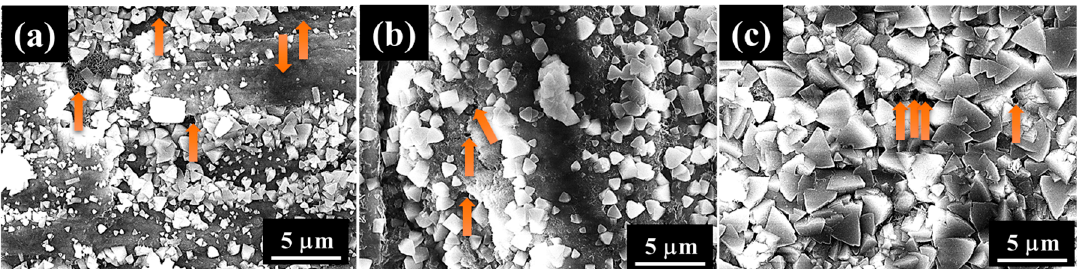
Figure 8. SEM images of films prepared at 423 K for 5 h on ( a ) AZ31, ( b ) AZ61, and ( c ) AZ91D after the immersion for 480 h in 5 mass% NaCl aqueous solution. All arrows show traces of pitting.